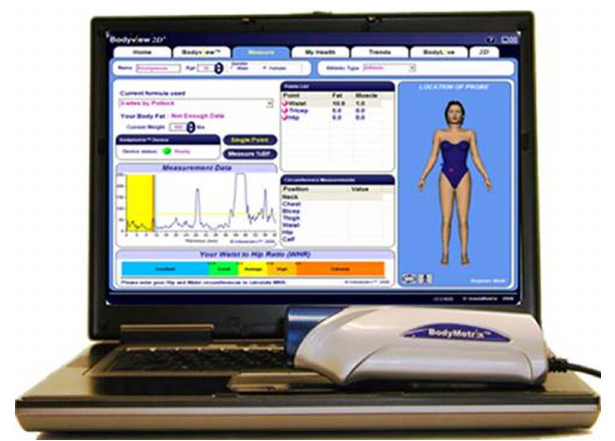
Figure 2. Image of the ultrasound transducer and correspond- ing software used for evaluation.